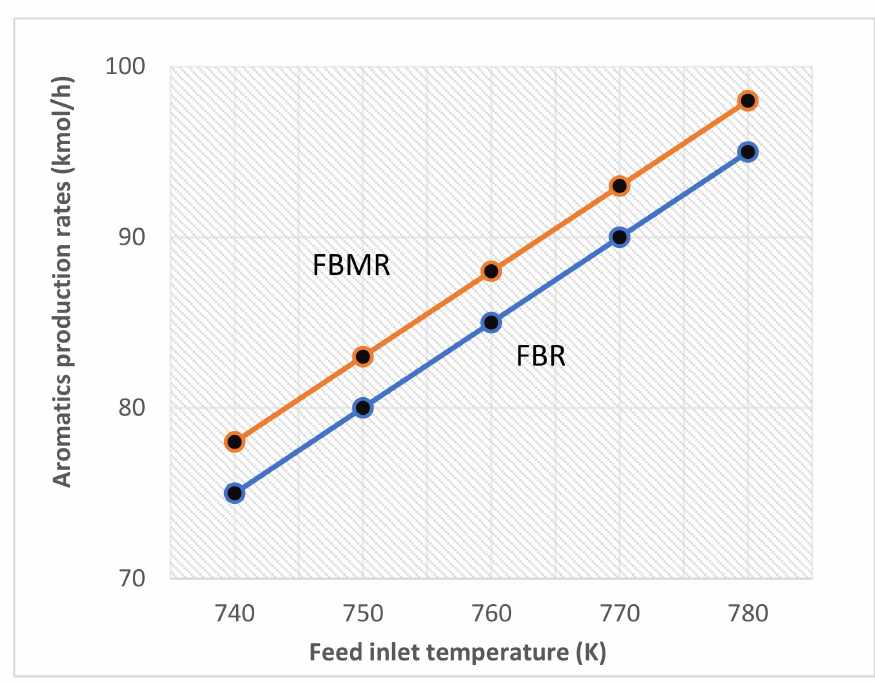
Figure 8. Effect of temperature on aromatic